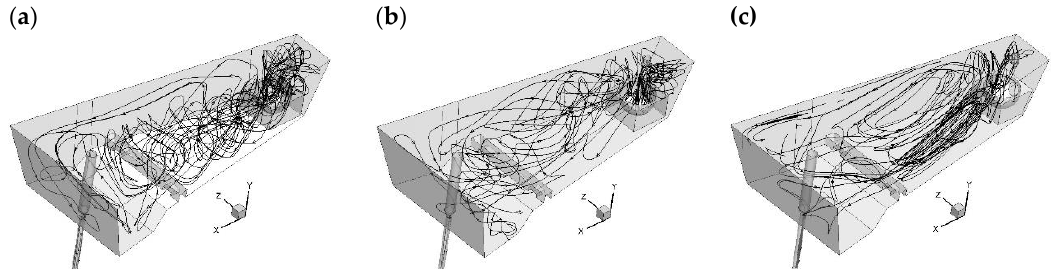
Figure 6. Liquid steel paths in the internal working volume of tundish for unsteady position of subflux turbulence controller and ladle shroud: ( a ) case No. 20, ( b ) case No. 21, and ( c ) case No. 22.